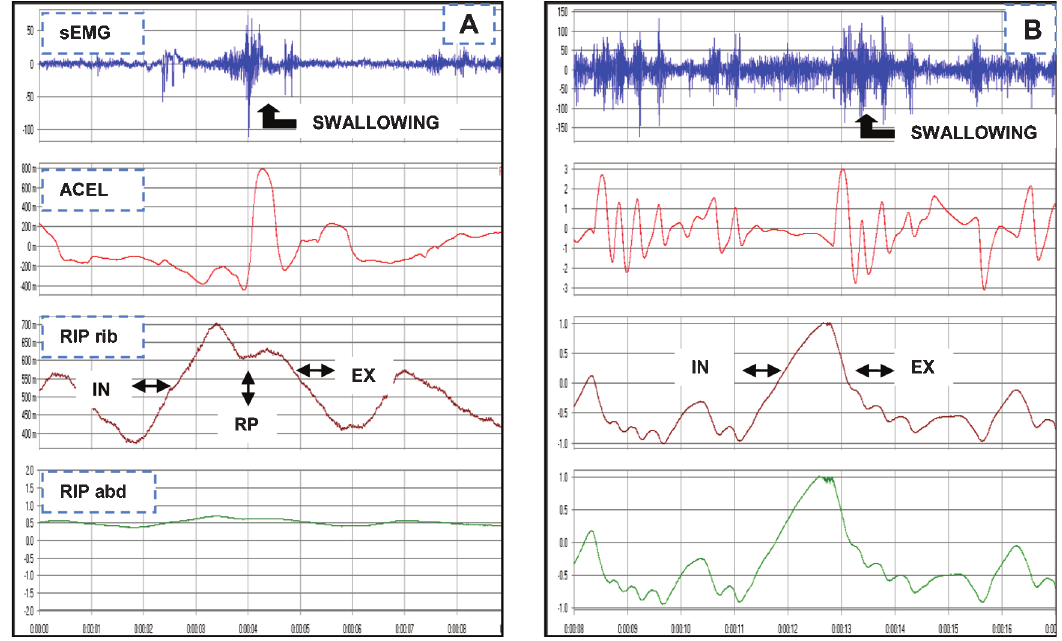
Figure 2 - Graphical demonstration of the integrated signals of the surface electromyography (sEMG), accelerometry sensor (ACEL), and inductive respiratory plethysmography (RIP) measurements in healthy volunteers (A) and patients (B) who swallowed 10 mL of water.